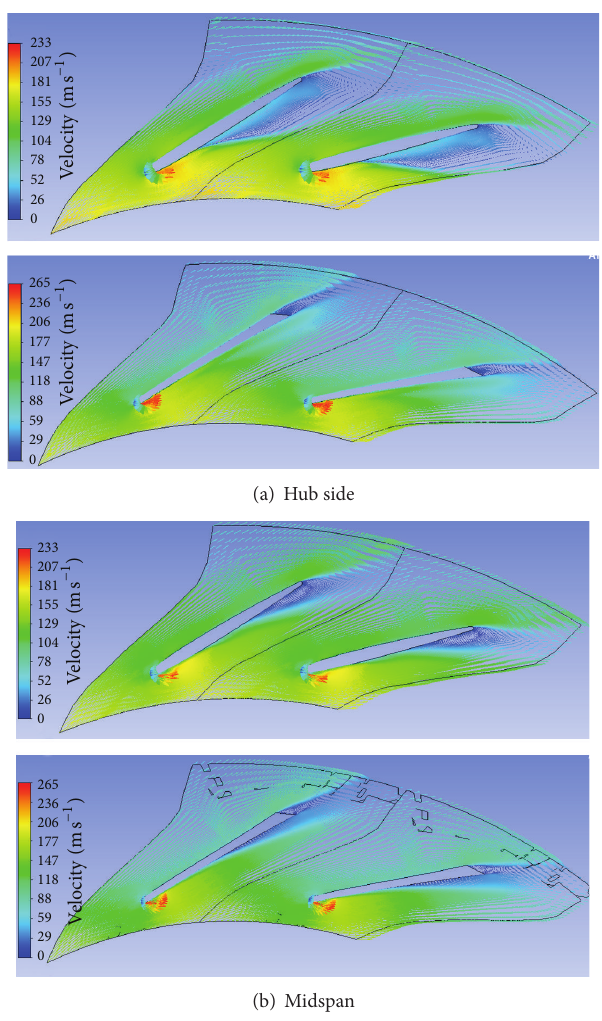
Figure8:VelocityvectorsfordifferentflowsurfacesofVD(top)and CD (bottom) at 𝑖 3 ≈ 4 ∘